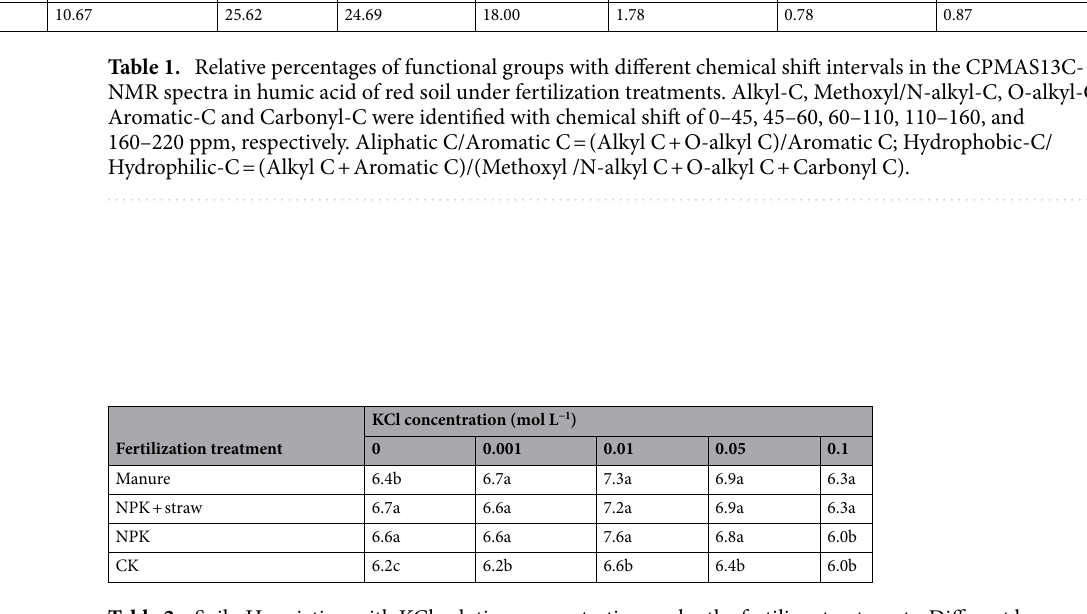
Table 2. Soil pH variation with KCl solution concentration under the fertilizer treatments. Different lowercase letters indicate significant differences of pH between the fertilization treatments across each KCl